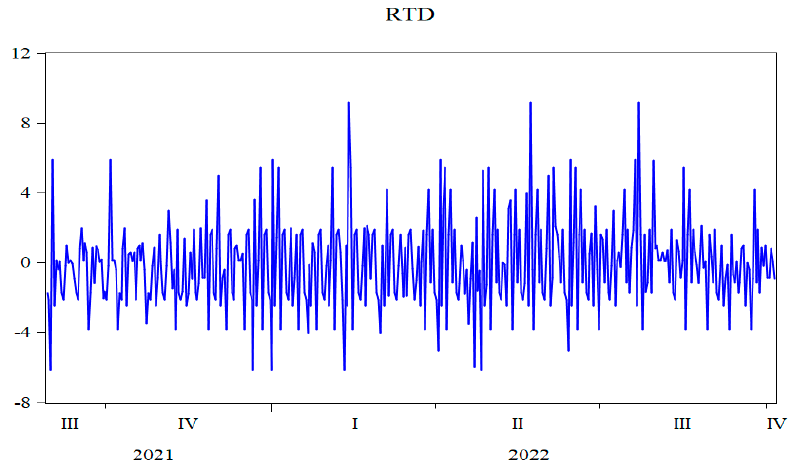
Figure 5. Relative tail dependence (RTD).